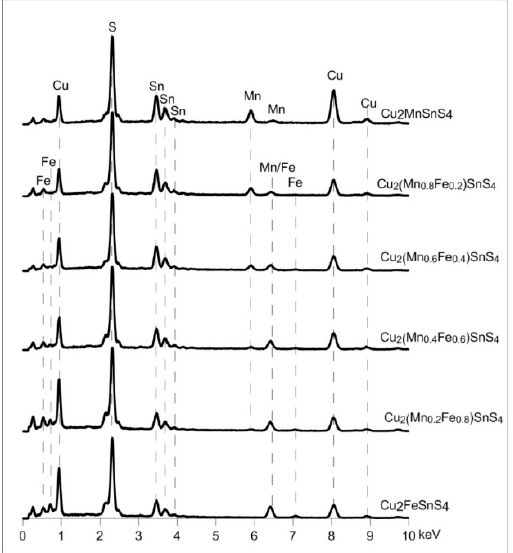
Figure 13. Elemental composition of Cu 2 (Mn 1 − x Fe x )SnS 4 solid solution series. All the samples have the composition close to what was expected from the synthesis. Table 1. Chemical composition (wt%) of Cu 2 (Mn 1-x Fe x )SnS 4 microcrystals from SEM/EDS analysis.